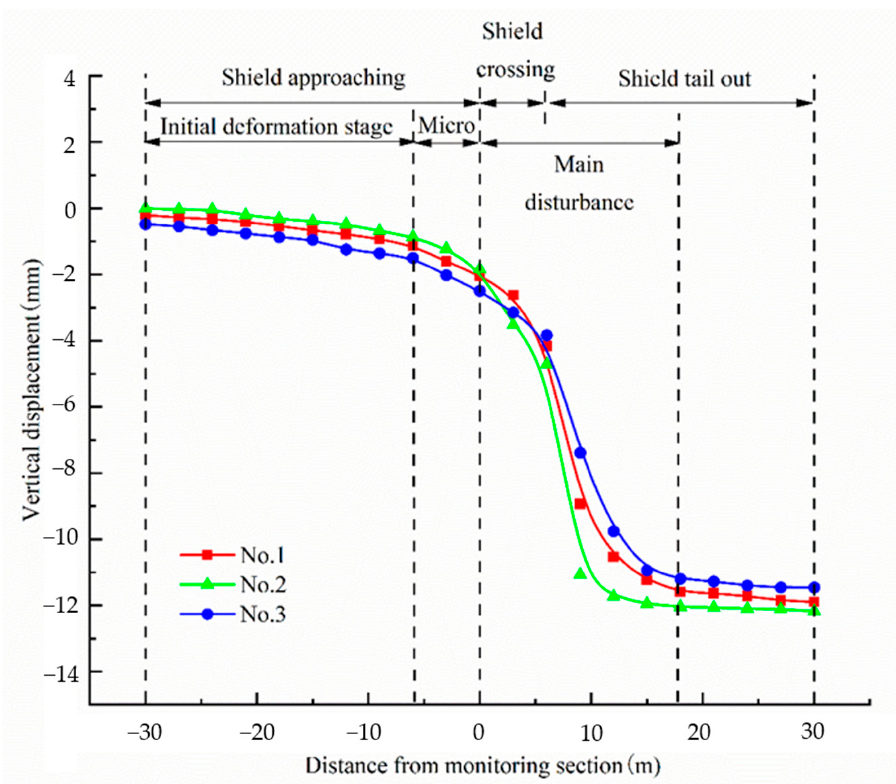
Figure 5. Variation of ground surface longitudinal settlement with the advancement of tunnel.